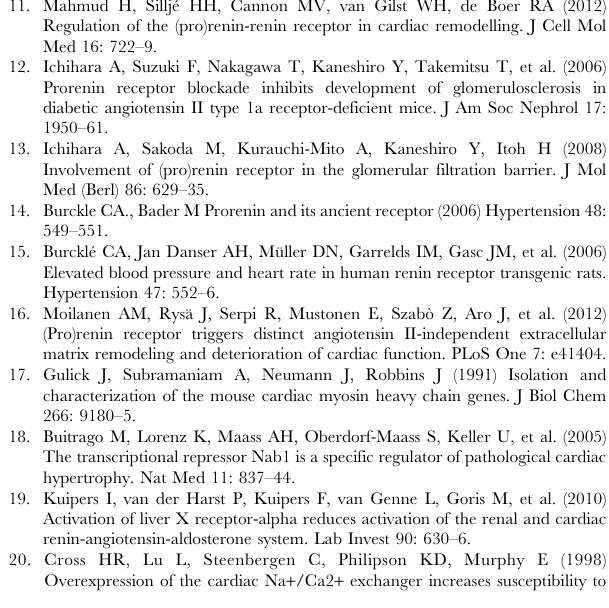
Figure S1 (P)RR mRNA expression in HeLa S3. RT-PCR analysis of (P)RR mRNA expression in control HeLa S3 cells (left bar) and (P)RR–overexpressing HeLa S3 cells (right bar) reveals , 130 fold upregulation in (P)RR levels (normalized to GAPDH ).